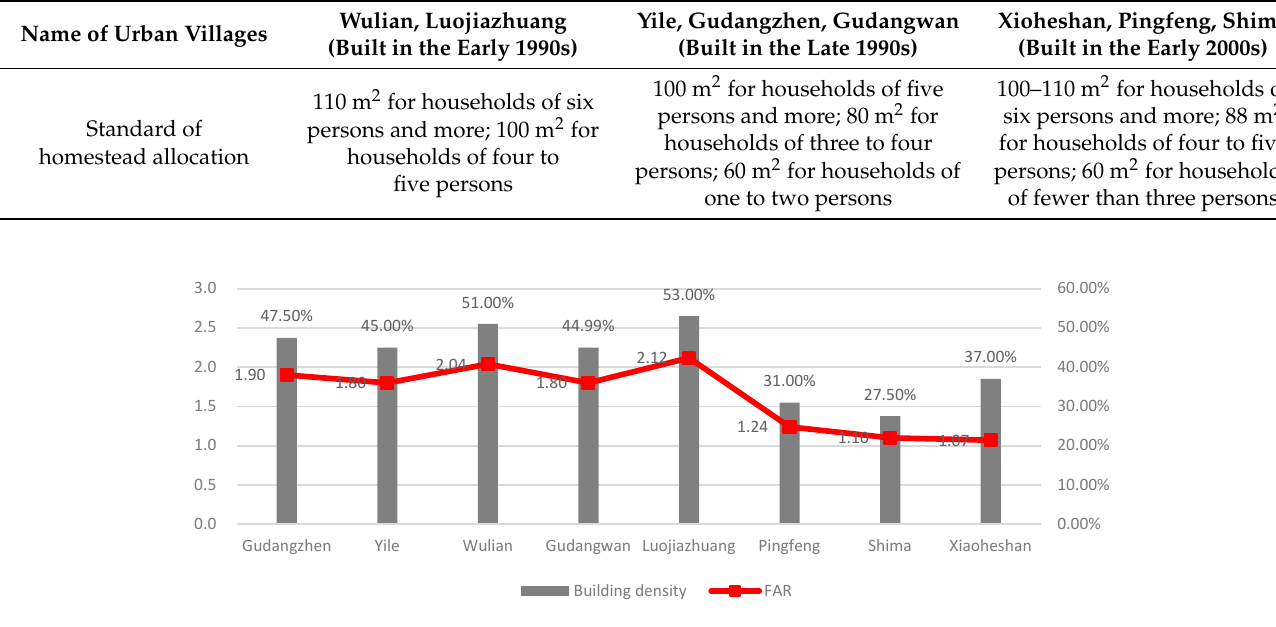
Figure 12. Building density and FAR of the urban villages of the first category. Additionally, there is also an evident difference in the rental level ratio to the sur- rounding apartment communities among the urban villages of the third category. Among them, Nanshan exhibits a significantly higher ratio in rental level, and Yuquan and Jiuxi exhibit a significantly higher ratio in growth rate. Compared to other urban villages of the third category, Nanshan, Jiuxi, and Yuquan exhibit a significant difference in the upgrading process. These three urban villages are all located at the junction between the scenic spot and the urban area and are closest to the West Lake, closest to the urban CBD, and closest